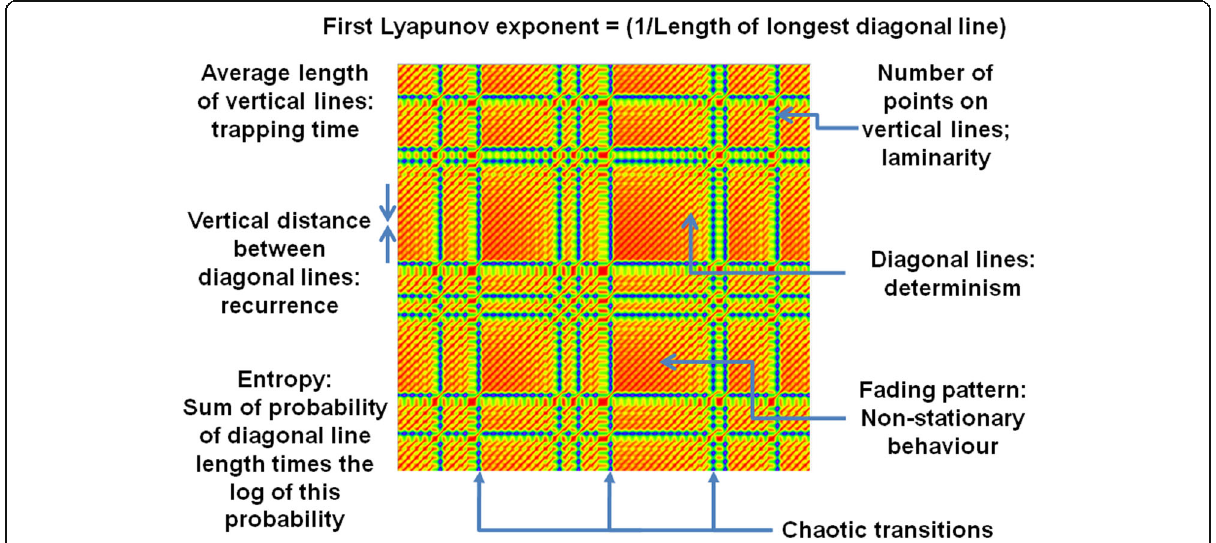
Fig. 3 A recurrence plot for the Lorentz attractor showing the significance of some of the RQA measures and of other features of the